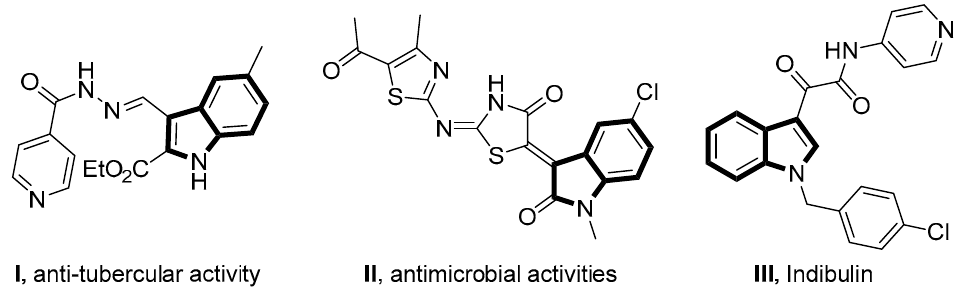
Figure 1. Selected biologically active compounds bearing indole-based